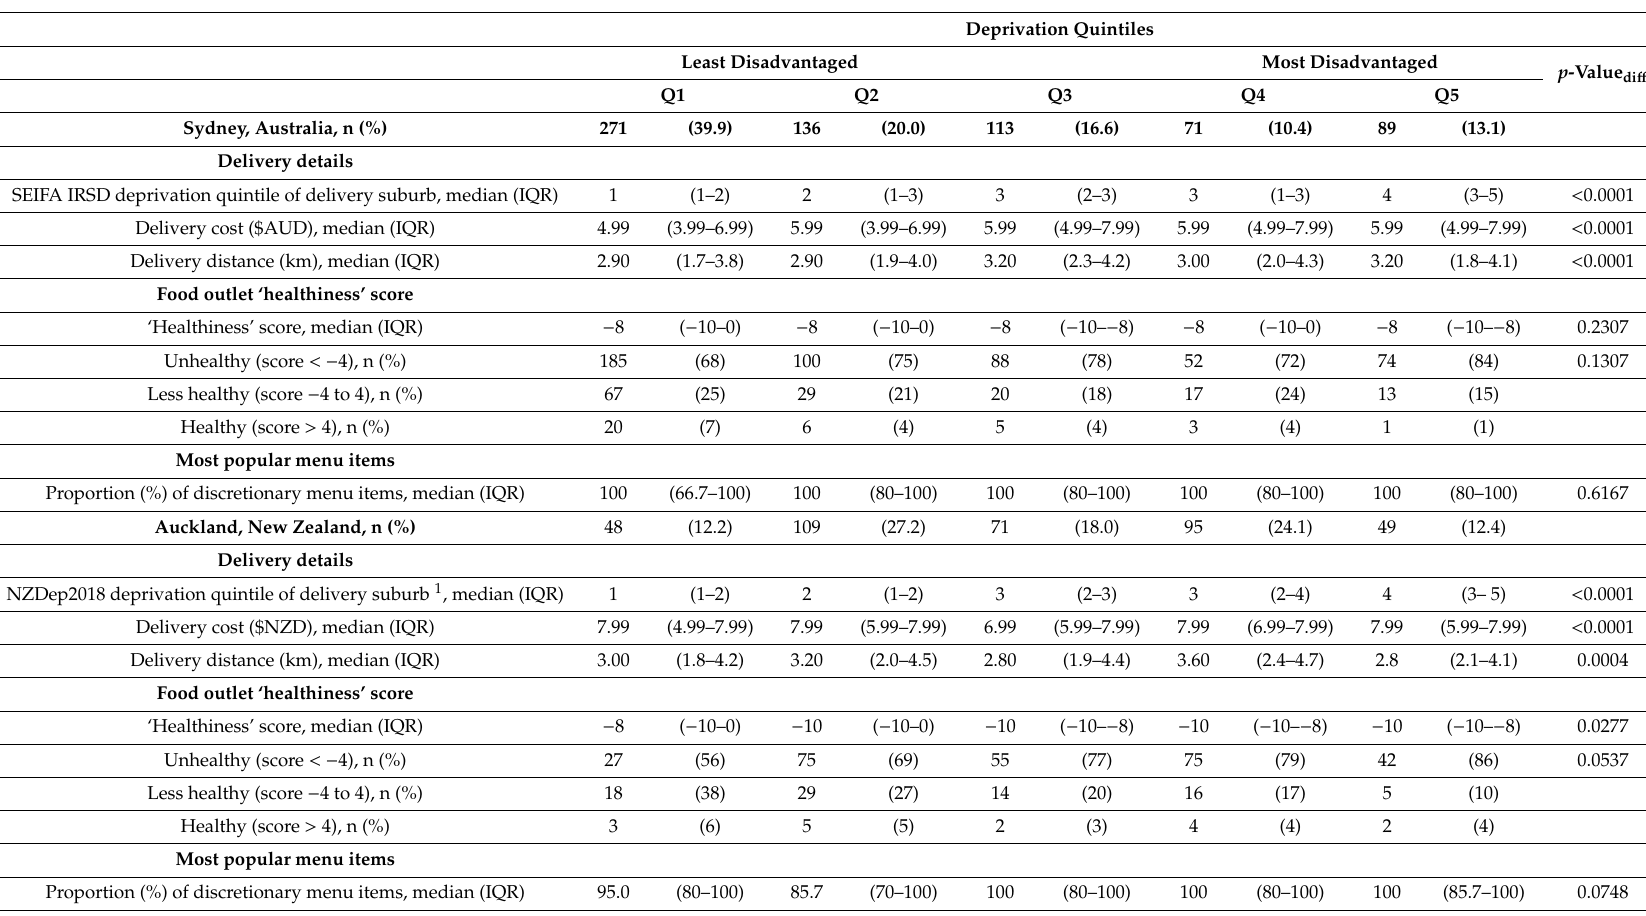
Table 4. Di ff erences between the deprivation quintiles of the physical food outlet location and food outlet characteristics available on Uber Eats in Sydney, Australia and Auckland, New